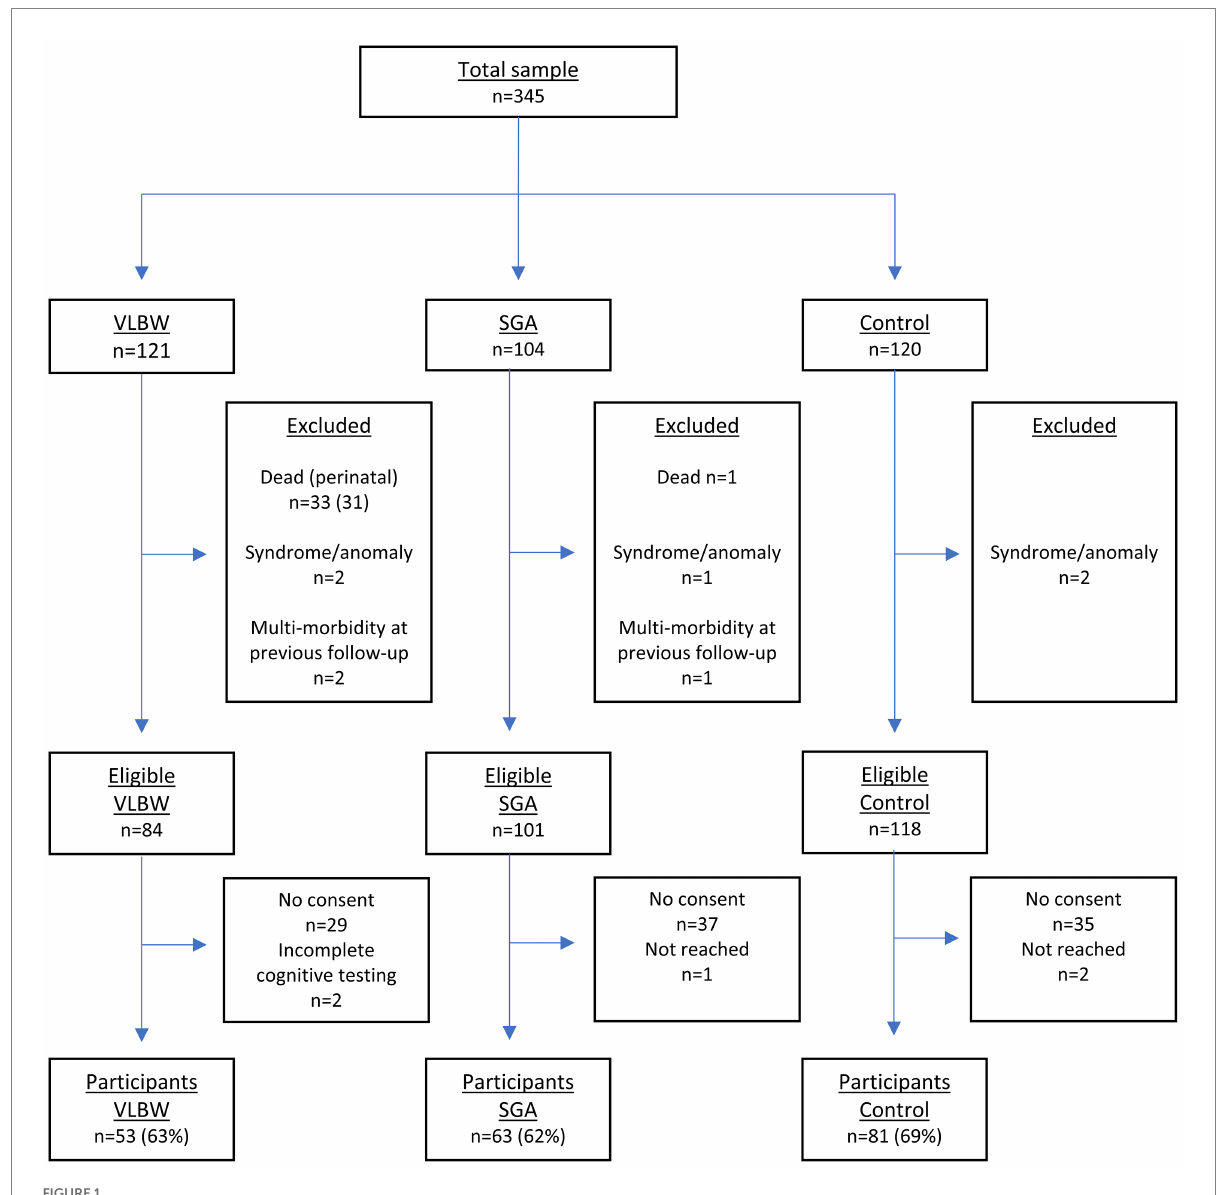
FIGURE 1 Flowchart of